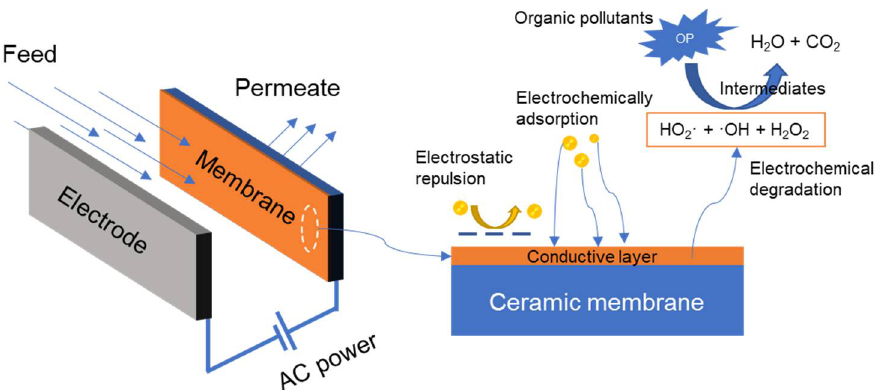
Figure 4. Schematic diagram of the electrochemically assisted membrane filtration